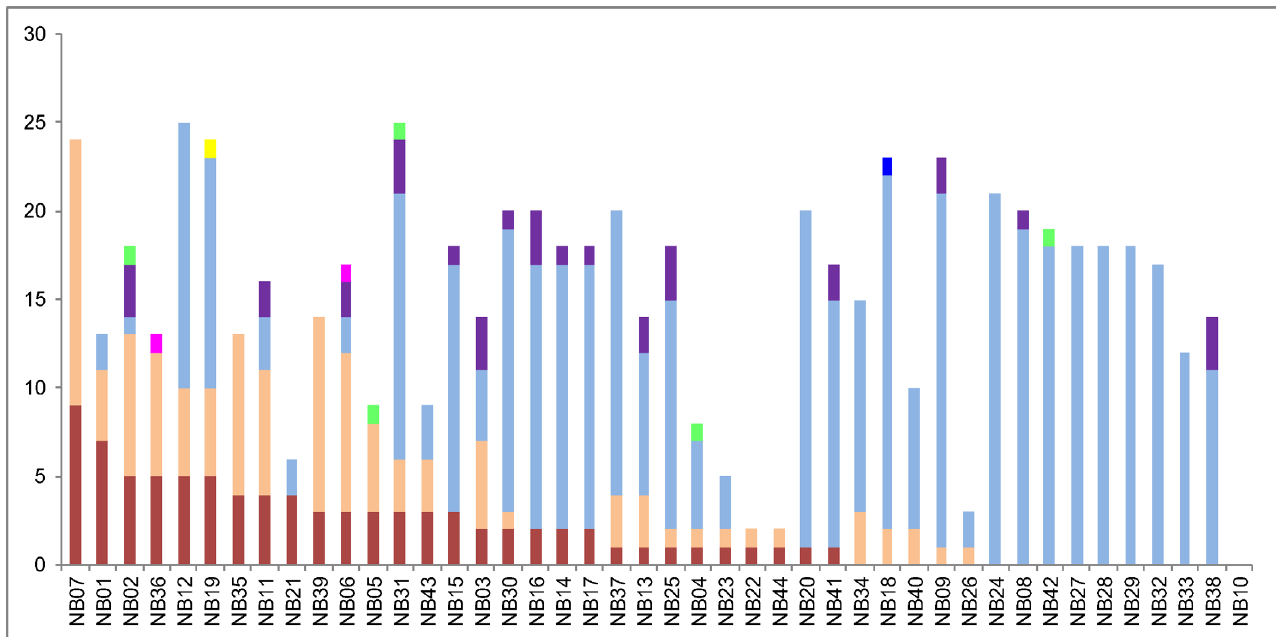
Fig 3. Number and type of chromosomal aberrations found in the cohort of 44 NB TTIs. Each bar represents one tumor. The number of NB typical segmental chromosomal aberrations (SCAs) is shown in red. SCAs with so far unknown prognostic relevance are shown in orange and numerical chromosomal aberrations (NCAs) are shown in blue. Whole chromosome copy neutral losses of heterozygosity are shown in purple. Presence of MYCN gene amplifications is shown in green, intragenic ATRX gene deletions in pink, hyper-rearrangements in dark blue and chromothripsis in